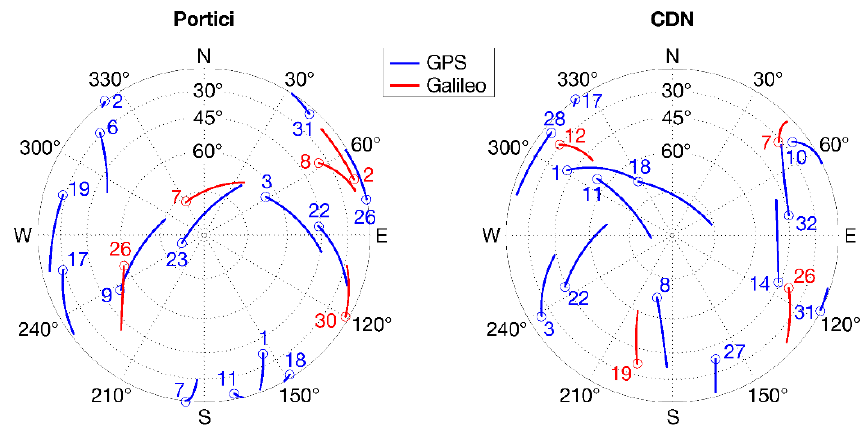
Figure 2. Skyplots of Portici and CDN sites ’ smartphone data. The beginning of the observational arc is represented by a circle. The GPS and Galileo satellites are shown in blue and red respectively.